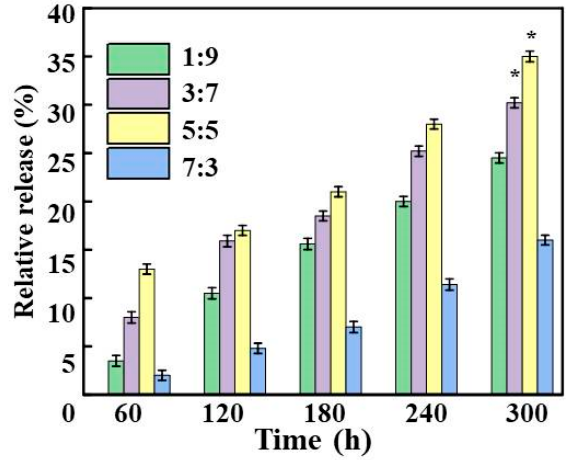
Figure 7. Relative release of OPO from different CS/OZN composite films.